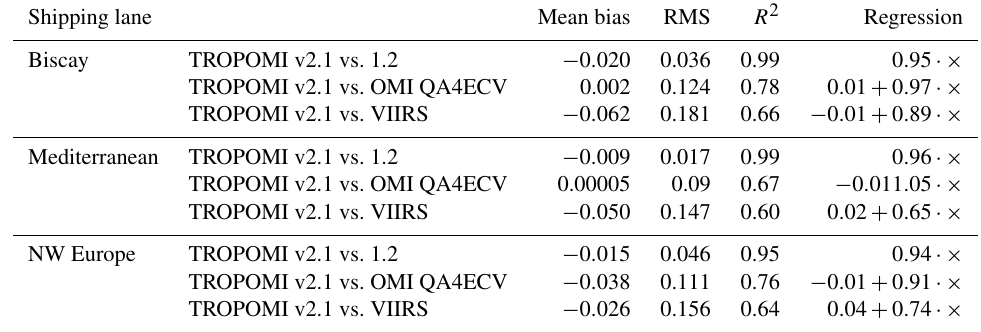
Table D1. Evaluation of TROPOMI v2.1 cloud fractions over European shipping lanes (1–6 July 2018) against reference data.